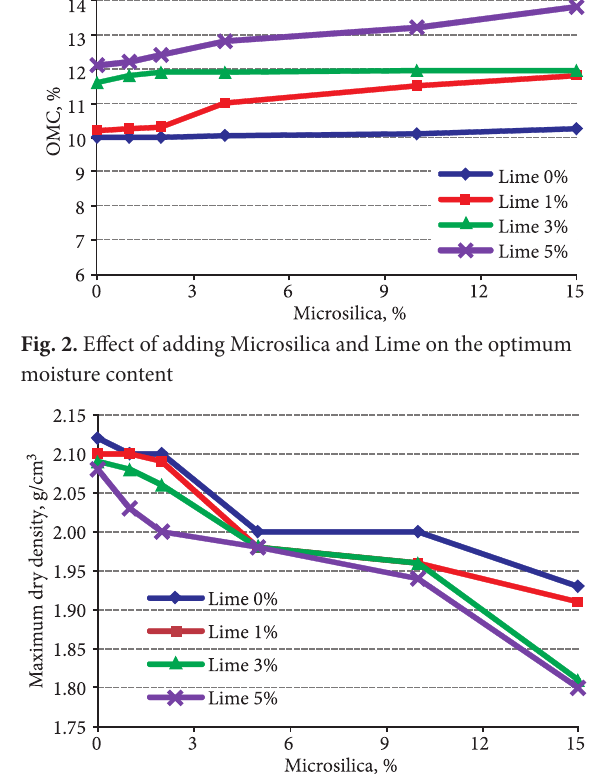
Fig. 3. Effect of adding Microsilica and Lime on max dry density of